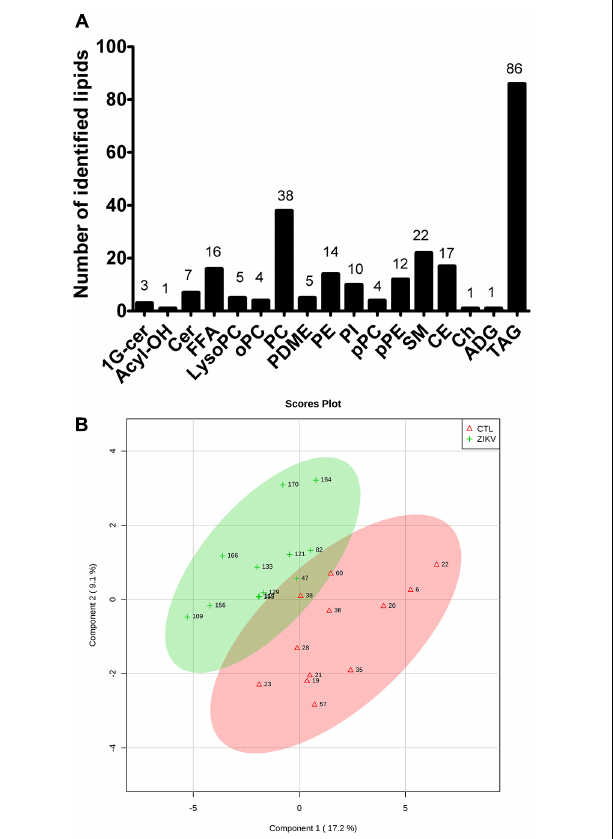
FIGURE 1 | Global lipidomics analysis of serum of ZIKV patients. Number of identified lipid species in ZIKV and control groups by untargeted LC-MS analysis (A) and sparse partial least squares discriminant analysis (sPLS-DA) of ZIKV infection (ZKV) and controls (CTL) (B) . 1G-cer, Glycosylceramide; Acyl-OH, Hydroxy-acyl; Cer, Ceramide; FFA, Free fatty acid; LysoPC, Lyso-phosphatidylcholine; oPC, Plasmenyl-phosphatidylcholine; PC, Phosphatidylcholine; PDME, Dimethylethanolamine; PE, Phosphatidylethanolamine; PI, Phosphatidylinositol; pPC, Plasmanyl-phosphatidylcholine; pPE, Plasmenyl-phosphatidylethanolamine; SM, Sphingomyelin; CE, Cholesteryl ester; Ch, Cholesterol; ADG, Alkyldiacylglycerol and TAG,